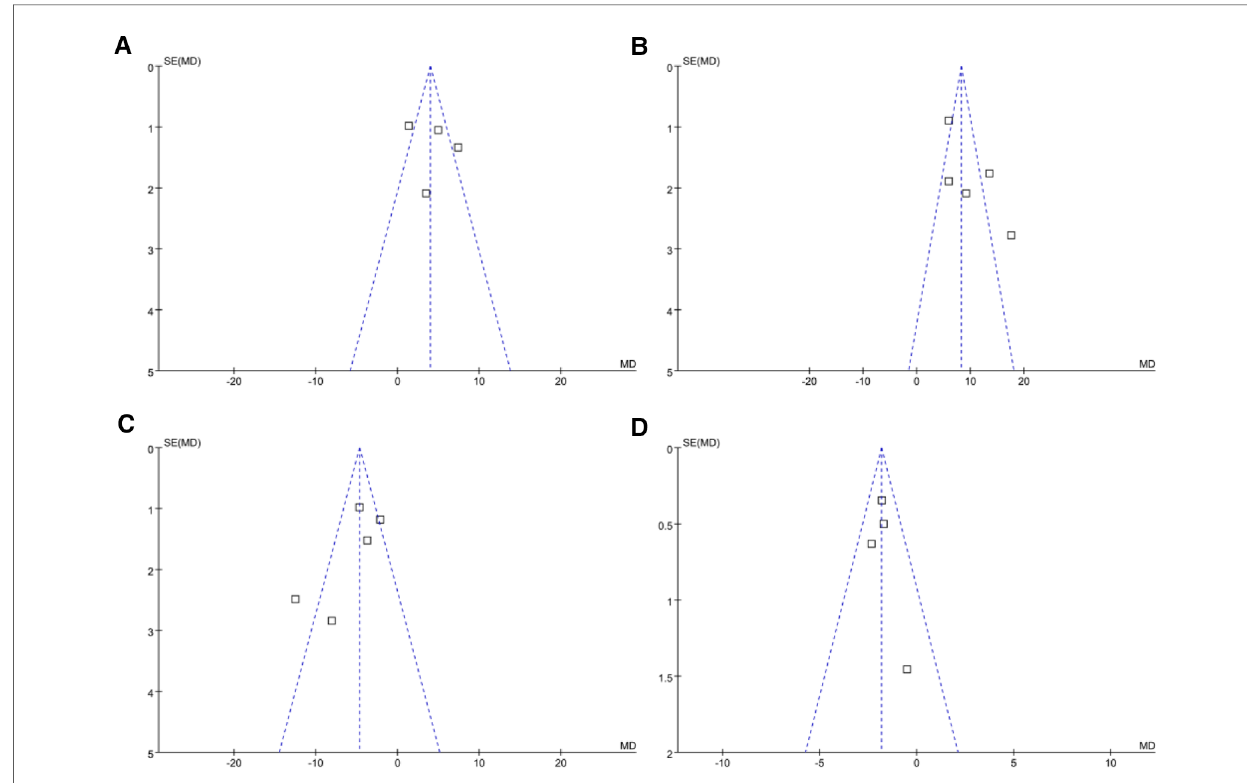
FIGURE 5 Funnel plots evaluating the publication biases of the meta-analyses. ( A ) Funnel plots for the meta-analysis of SaO 2 ; ( B ) Funnel plots for the meta-analysis of PaO 2 ; ( C ) Funnel plots for the meta-analysis of PaCO 2 ; and ( D ) funnel plots for the meta-analysis of